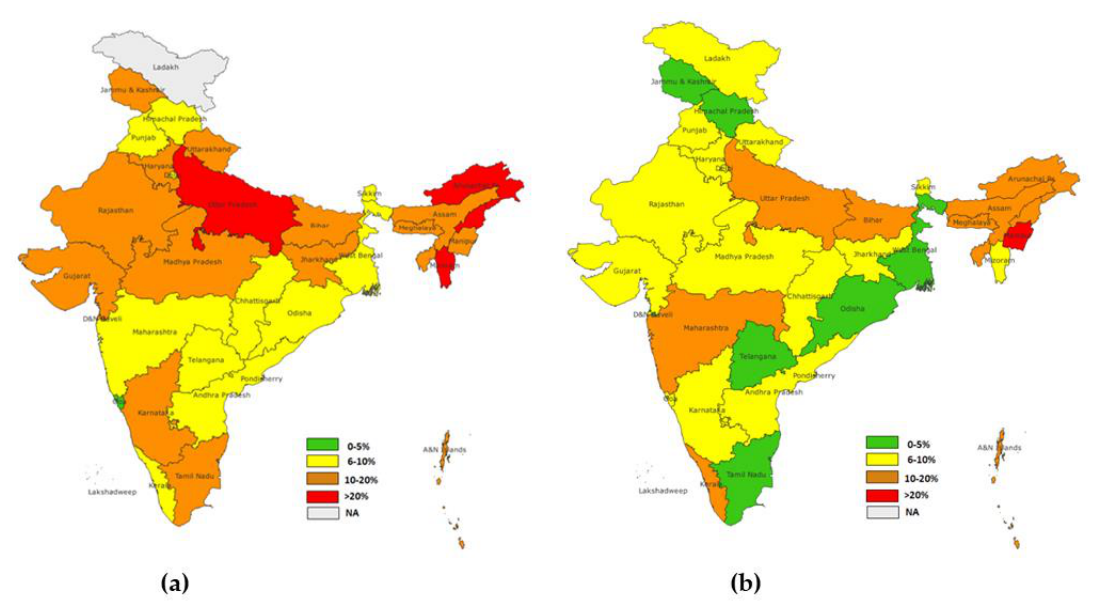
Figure 4. ( a ) State-level dropout rate for BCG-MCV1(NFHS-4), ( b ) state-level dropout rate for BCG MCV1(NFHS-5).